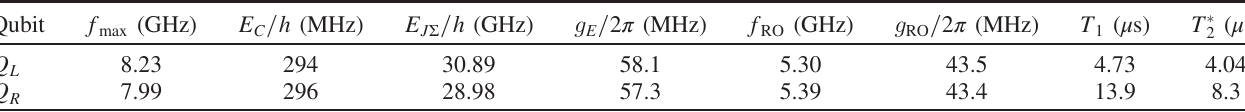
( E ) is the charging (Josephson) C J Σ is coupled to the RO